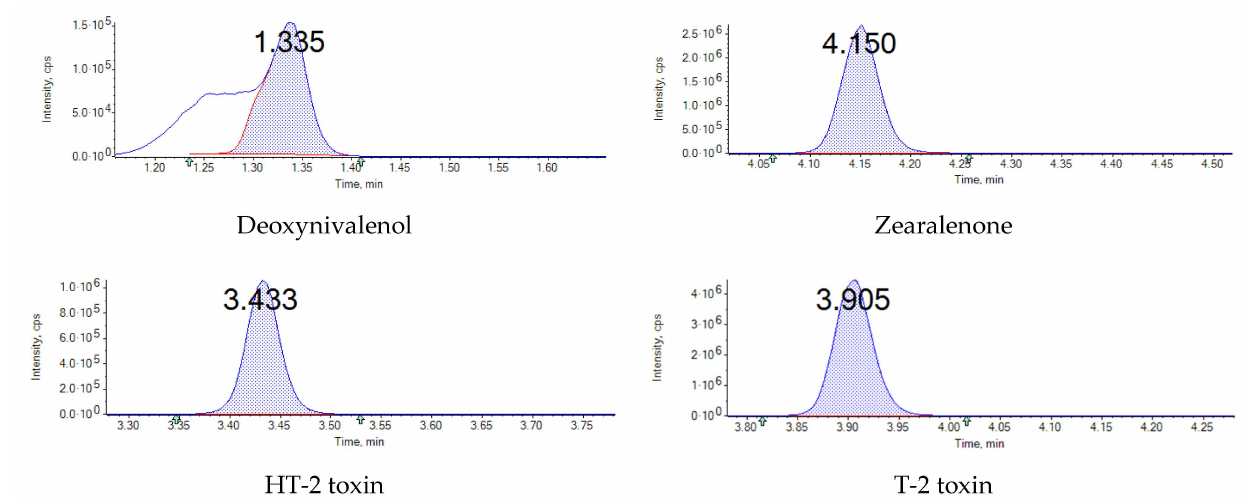
Figure 1. MRM chromatogram of investigated mycotoxins in mycotoxin-free oat samples spiked at 10 µ g · kg − 1